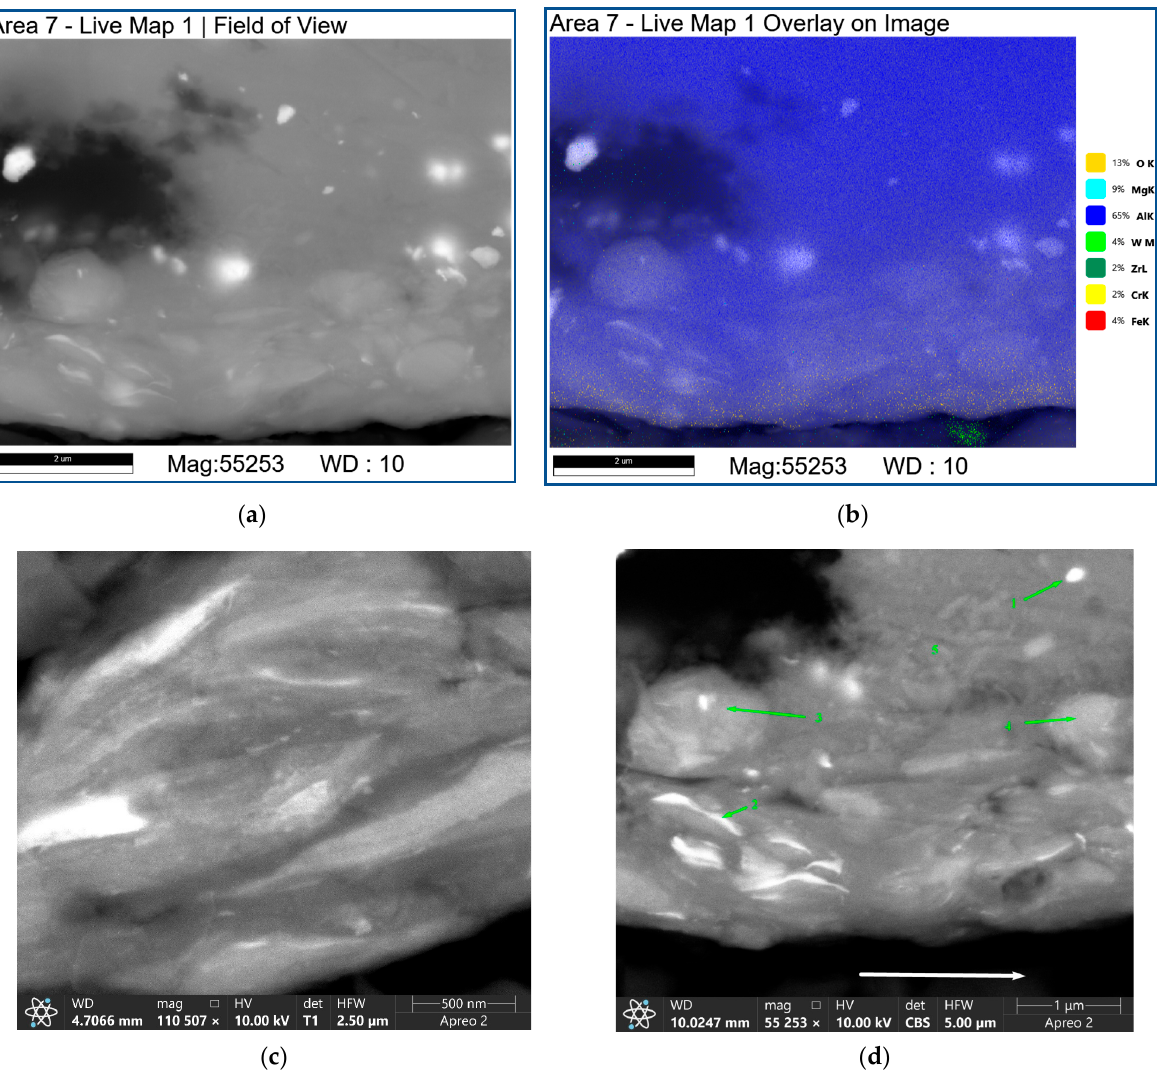
Figure 25. The SEM BSE images ( a , c , d ) and layered EDS images ( d ) of microstructures formed by sliding below the worn surface of FSP-ed RPPs/AA5056 composites after 8 passes. Numbers on ( d ) indicate probe zones for which EDS elemental concentrations were determined indicated in Table 5. The white arrow on ( d ) shows the direction of sliding. Table 5. Chemical composition (EDS) of the of microstructures formed by sliding below the worn surface of FSP-ed RPPs/AA5056 composites after 8 passes (Figure 25).